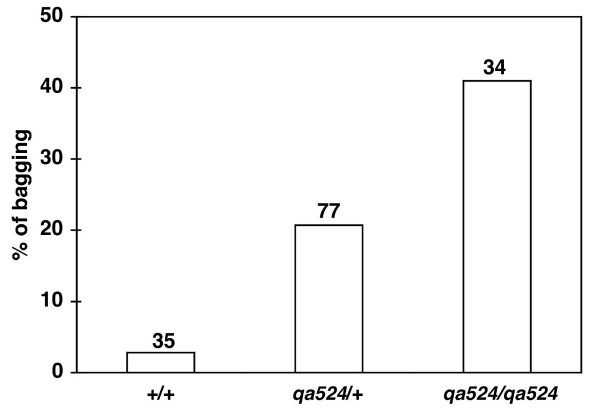
Haploinsufficiency of nfi-1 locus. Egg-laying defect in progeny of nfi-1 heterozygous mutant animals are shown. Bagging was scored in all progeny of two nfi-1(qa524/+) heterozygous worms (n = 146) derived from eggs laid over 7 hours. All worms were genotyped by single-worm PCR. Bars represent % of bagging in wild type (+/+), nfi-1 heterozygous (qa524/+) and nfi-1 homozygous worms (qa524/qa524). The number of worms scored of each genotype are shown above the bars.